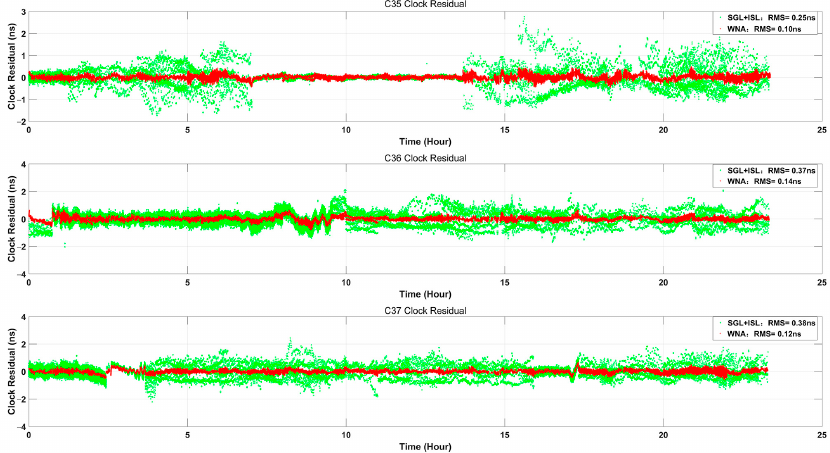
Figure 6. Clock residuals.